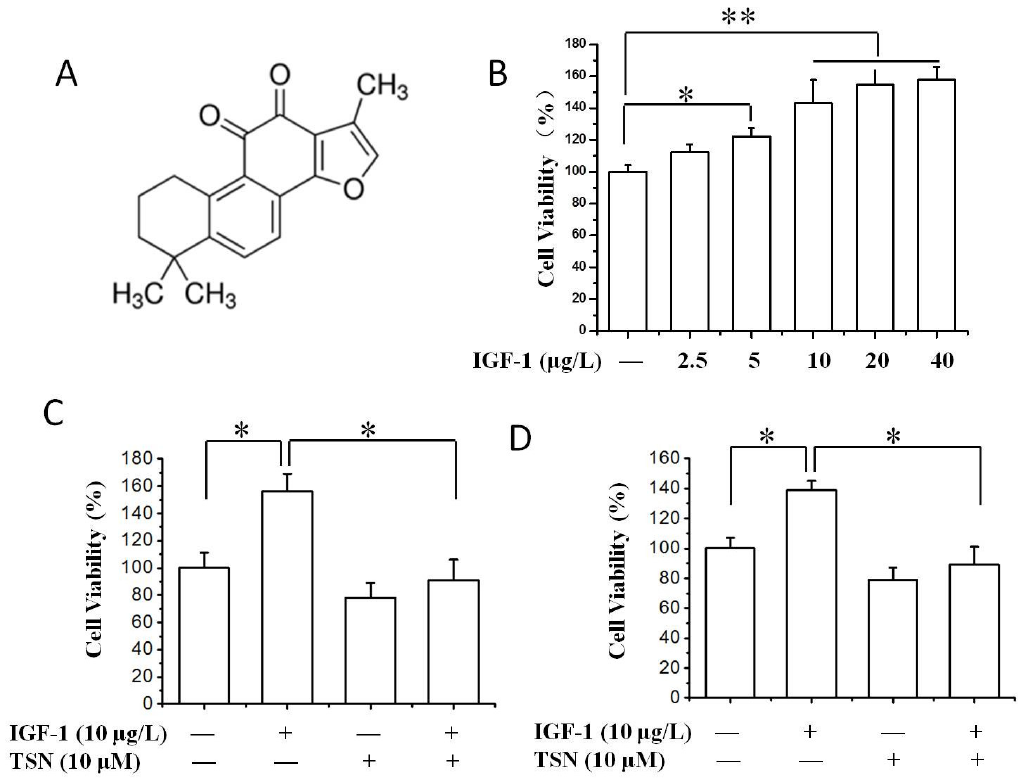
Figure 1. Tanshinone IIA (TSN) attenuated IGF-1-induced cell proliferation in PC12 cells. ( A ) Chemical structure of TSN; ( B ) The effect of IGF-1 on PC12 cell proliferation. The cells were treated with various concentrations of IGF-1 (0–40 µg/L) in a serum-free medium for 24 h; cell proliferation was evaluated by methyl thiazolytetrazolium (MTT) assay; ( C ) Effect of TSN on IGF-1-induced cell proliferation in PC12 cells. Cells were treated with TSN (10 µM) for 1 h, and then were treated with IGF-1 in a serum-free medium for 24 h. Cell proliferation was determined by MTT assay; ( D ) Cells were treated with TSN and IGF-1 in a serum-free medium for 24 h. Cell proliferation was determined by CCK-8 assay. Each graph represents data from triplicates in separate experiments. Values were expressed as mean ± SEM. * p < 0.05, ** p < 0.01.